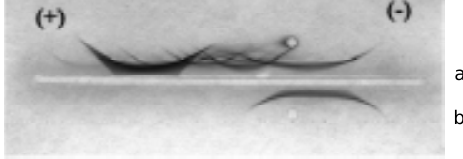
Figure 3 - Immunoelectrophore- sis. a , Plasma pool (2 µl of 10 g/ l); b , immunoglobulin G (2 µl of 30 g/l). Protein was detected with light green stain.